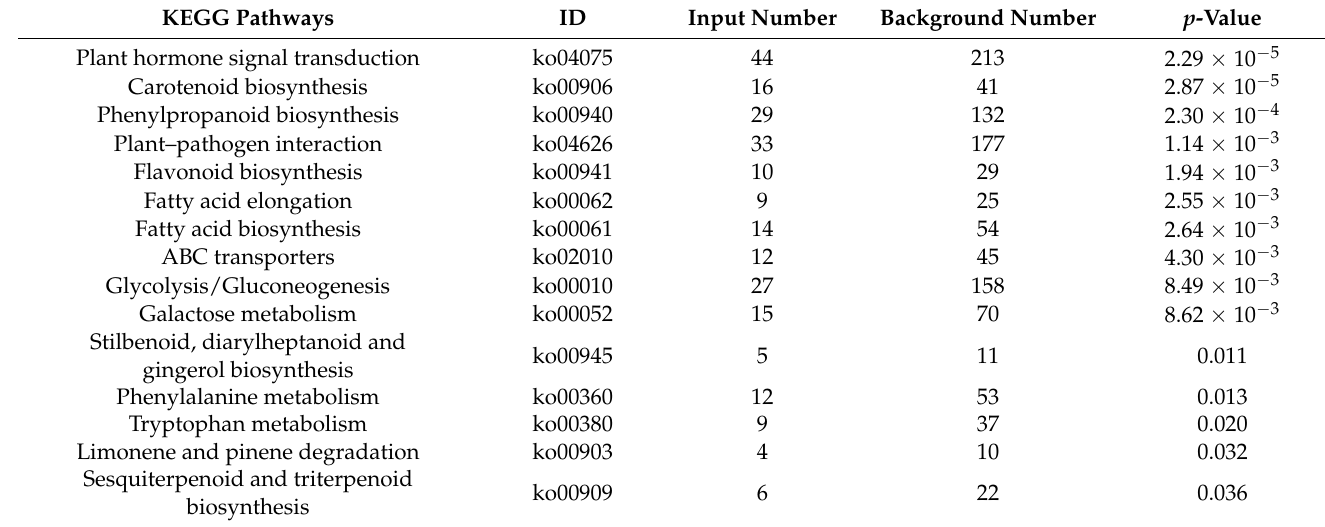
Table 3. KEGG enrichment analysis of DEGs identified between ‘Changying’ and ‘Huiyuan’ fruits. ID Input Number Background Number p